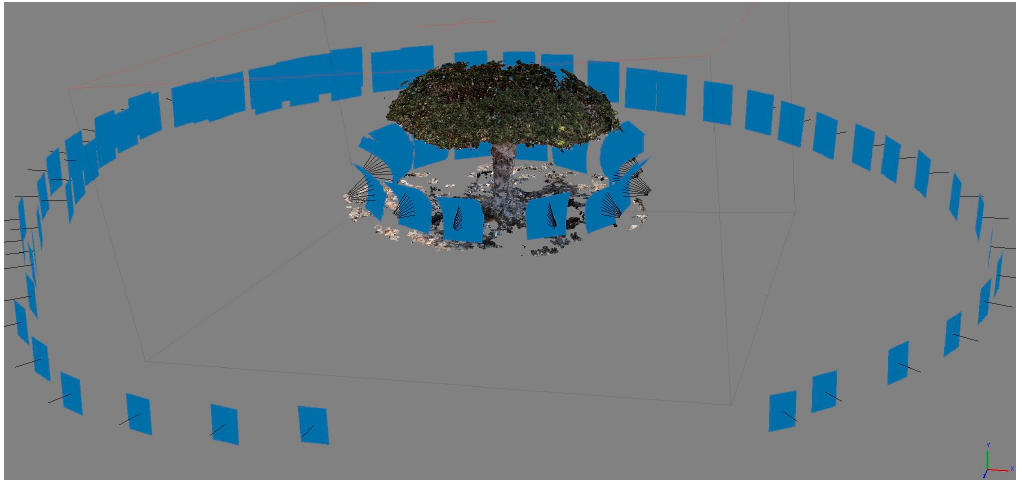
Figure 1. Method (a)—position of captured photos to create a photogrammetric 3D tree point cloud. The outer circle of photos captures the whole tree shape. The inner circle of photos consists of the number of photos captured from the same location with various vertical angles to capture the tree structure in detail. Locations are situated all around the tree.